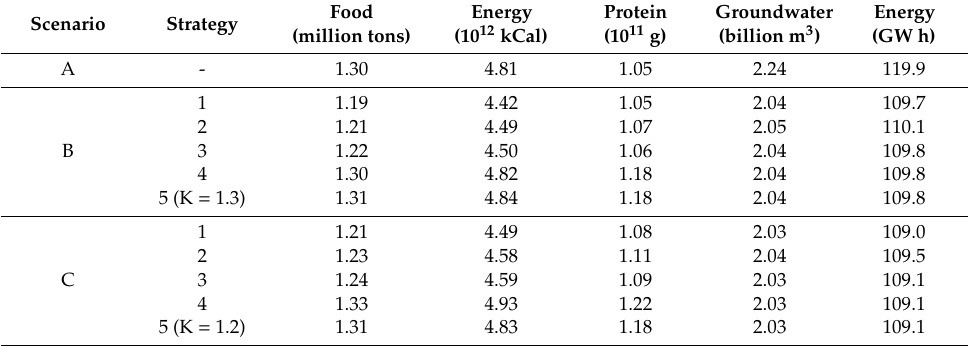
Table 5. Comparison of food production and associated groundwater and energy consumption between Scenarios A, B, and